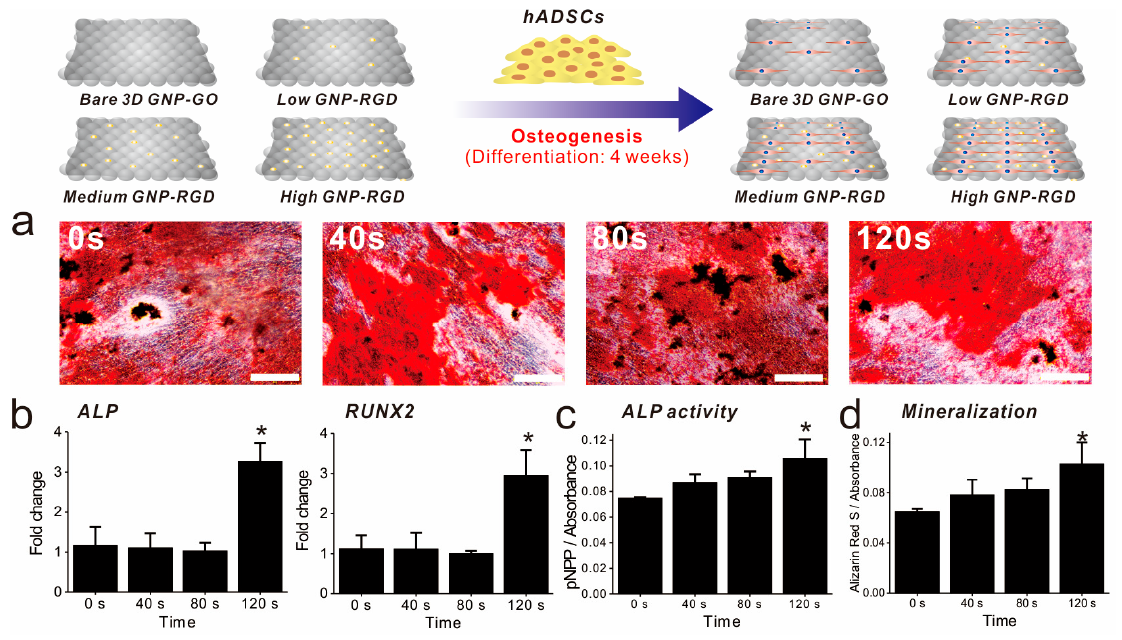
Figure 5. Confirmation of ADSC osteogenic differentiation. ( a ) Alizarin Red S staining of all substrates. Scale bars = 200 μ m. ( b ) RT-qPCR data for alkaline phosphatase (ALP), and RUNX2. ( c ) The ALP activity of each substrate. ( d ) Absorbance rates after Alizarin Red S (ARS) staining. * Student’s t -test, p < 0.05, n = 3.